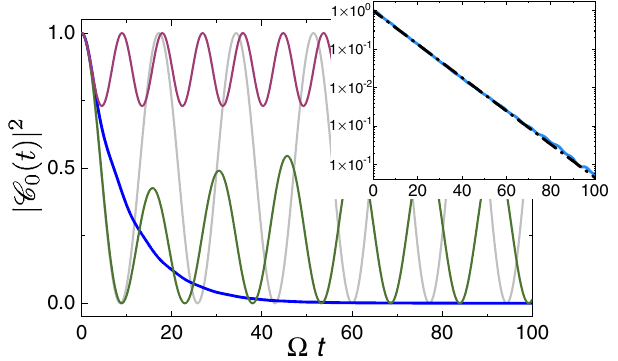
FIG. 2. Decay of the qubit population, j C 0 ð t Þj 2 , calculated numerically based on the presented model. We assume N ¼ 10 5 oscillators with uniform distribution of couplings between the ≤ γ qubit and reservoir 0 ≤ γ , with overall decay rate i i; max 0 . 1 Ω . The blue decaying line shows the fully random Γ 0 ¼ case with uniform distribution of energies of the oscillators ( Δ ω ¼ 2 Ω ). Inset: The dash dotted line shows the exponential decay j C 0 ð t Þj 2 ≃ exp ð − Γ 0 t Þ closely following the numerical result shown by a solid blue line calculated as in the main panel but with N ¼ 10 6 for increased accuracy. The rest of the curves in the main panel demonstrate the significance of the randomness of reservoir parameters and couplings on qubit decay. The gray line [pure cos 2 ð Λ 0 t Þ ] is the result for Δ ω ¼ 0 , i.e., for oscillators Ω . The green line presents which all have the same energy ω k ¼ an intermediate case with Δ ω ¼ 0 . 3 Ω with partial revivals. Finally, the dark red line is for the oscillators all having the 0 . 4 Ω . In this case, the population of the qubit frequency ω k ¼ never vanishes but oscillates between a nonzero value and unity. All the traces are aligned at short times up to Ω t ≃ 3